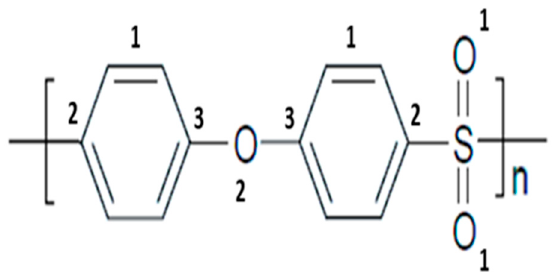
Figure 1. Structure of PES illustrating three different C bondings: (1) C=C, (2) C-S, and (3) C-O and two O bondings: (1) O=S, and (2) O-C.